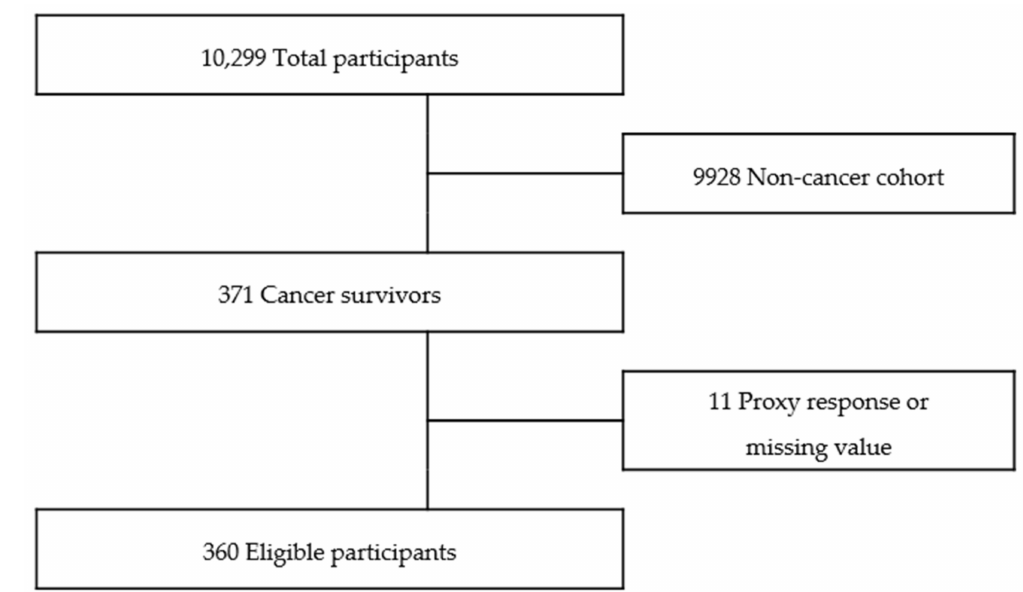
Figure 1. Flow diagram of inclusion of study